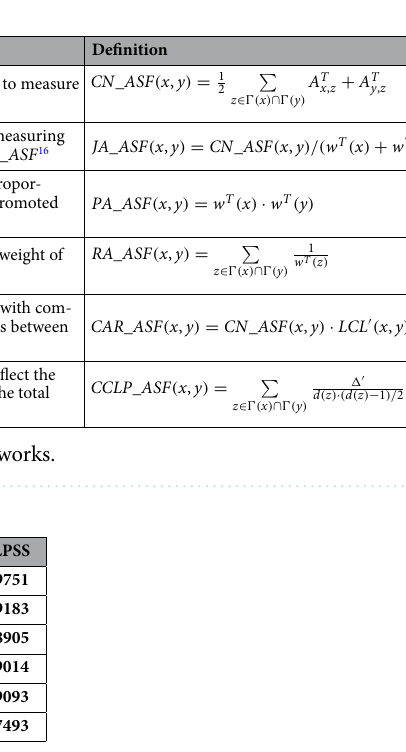
Table 4. Comparison of the AUC value between TLPSS and baseline methods. Significant values are in bold.